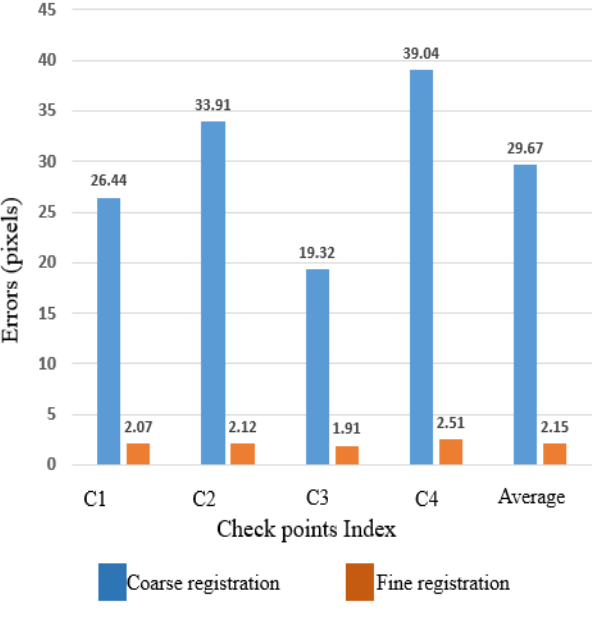
Figure 5. comparison between coarse and fine registration accuracies on the check